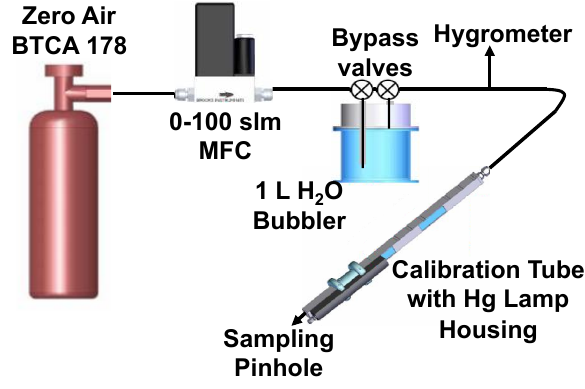
Fig. 4. Schematic representation of the calibration system. Zero air is humidified and passed through the calibration tube, where it is photolysed to produce a known concentration of OH and HO 2